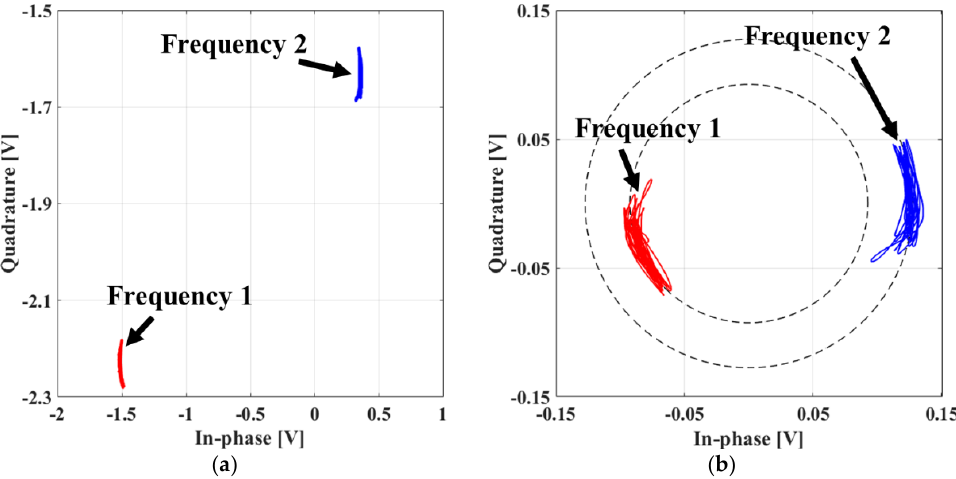
Figure 5. Direct-current (DC) offset calibration on the complex plane: ( a ) Uncalibrated signals of each frequency in the baseband; ( b ) Calibrated signals of each frequency based on the Pratt method.